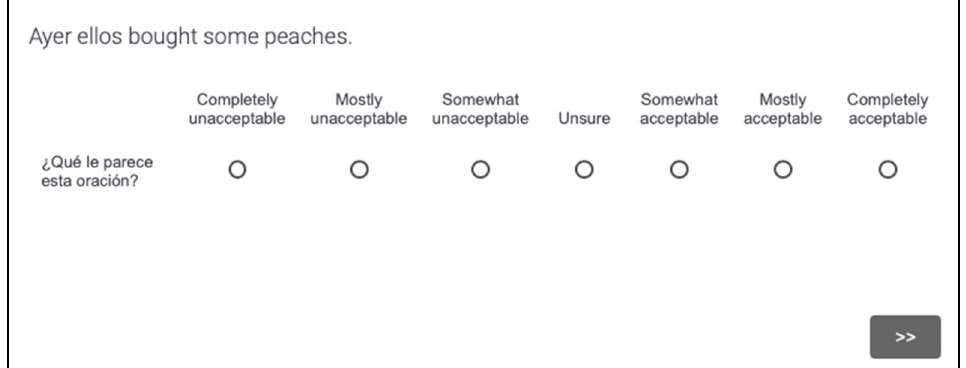
Figure 1. Example stimulus from the CS block of the AJT.